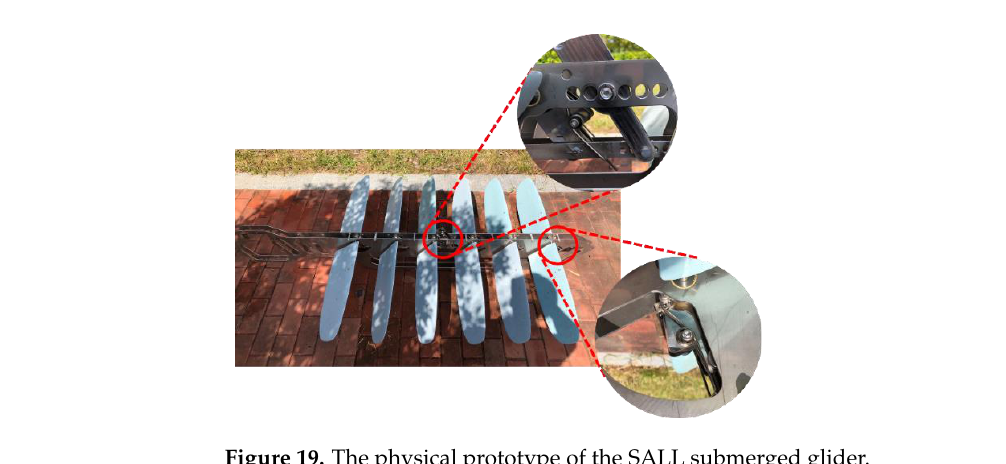
Figure 18. The structure of the SALL submerged glider. ( a ) The installation diagram of the torsion spring; ( b ) the internal structure diagram; and ( c ) the parallelogram mechanism.